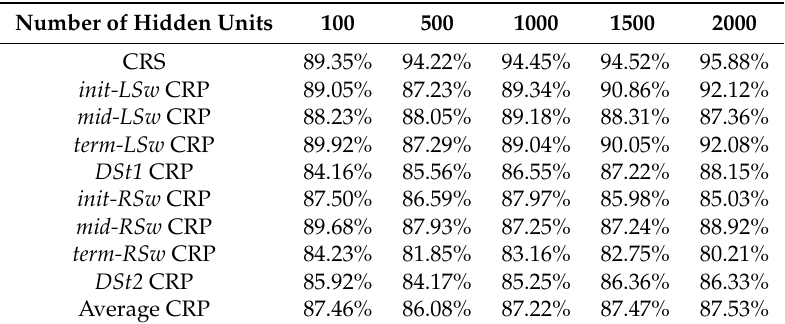
Table 7. The average testing set CRS and CRP of the gait phase recognition model through 5-fold cross-validation for different numbers of hidden units.